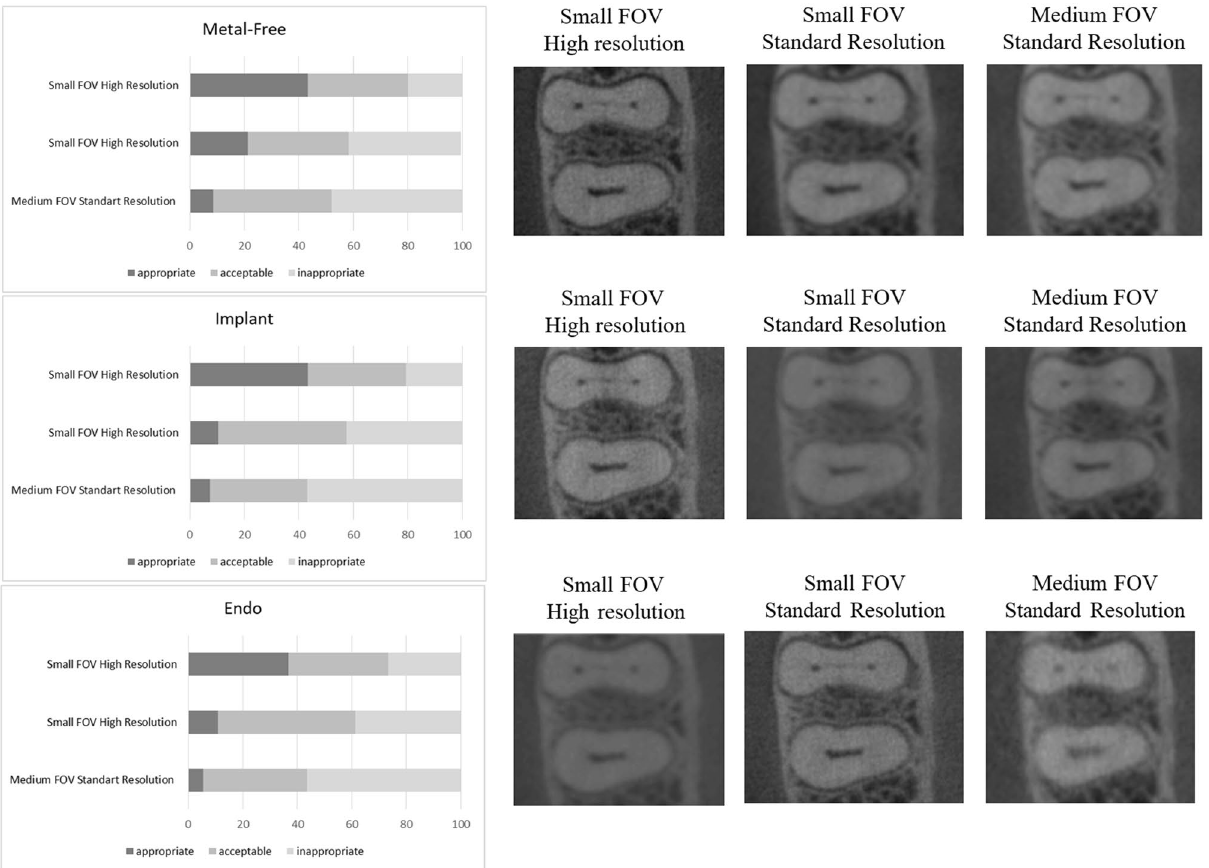
Figure 5. Stacked bar graphs showing the percentage of appropriate, acceptable or inappropriate scores taking into account all CBCT devices for the three scanning protocols and representative images of isthmus from device A.